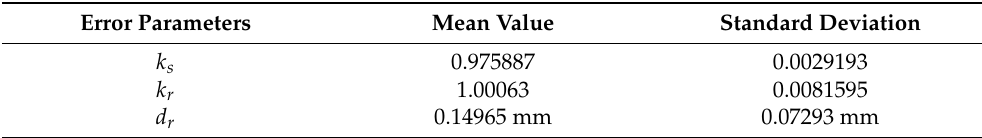
Table 1. Error parameters estimated by the experiment.